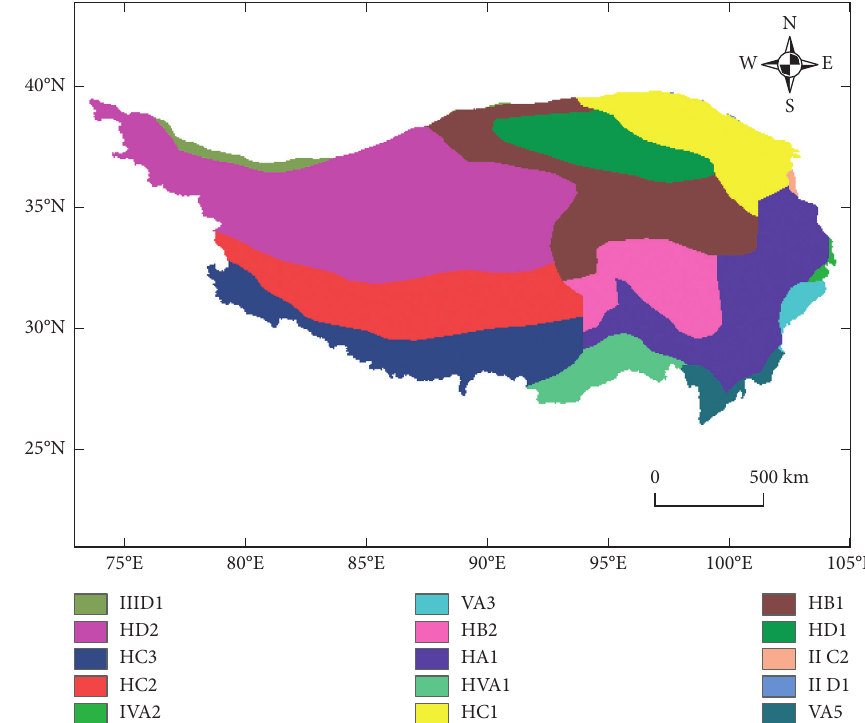
Figure 7: The climate regionalization in the QTP.